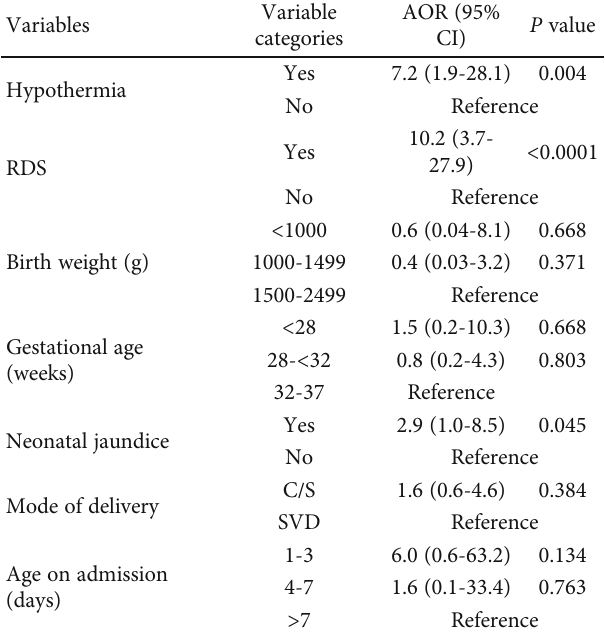
∗ N =number of patients in a category; n =number in a category who died or were discharged. Table 5: Multiple logistic regression analysis of determinants of treatment success of preterm